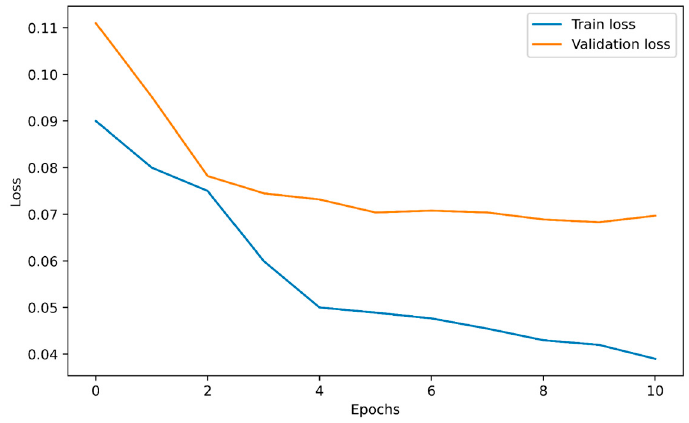
Figure 8. Loss plot for multiclass classification (9 classes).